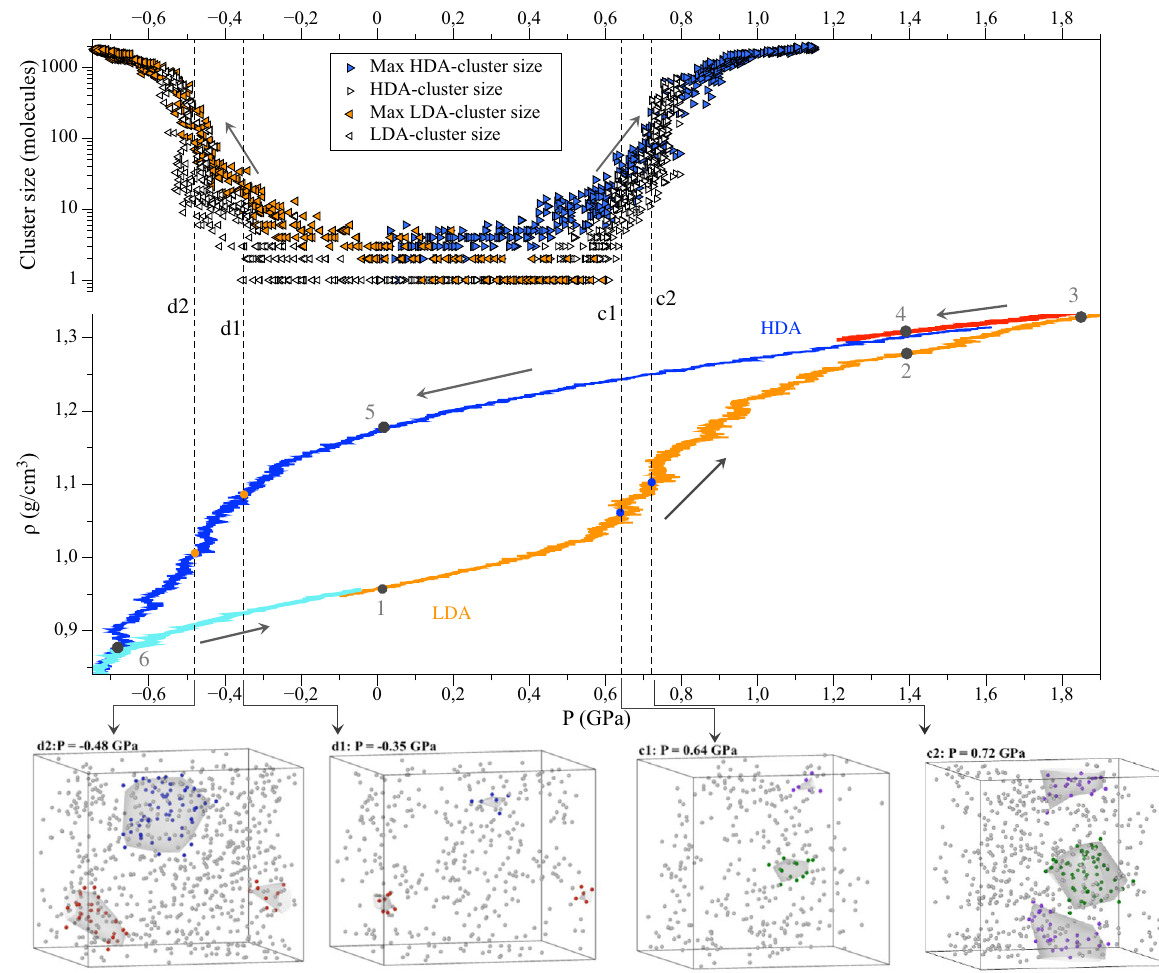
Figure 4. The pressure dependence of density during the transformations of amorphous ices under pressure at T = 77 K , the compression rate is 0.1 GPa/ns. The arrows indicate the cycle direction. On the route 4 → 5 , the blue line is the decompression of HDA obtained during SSA from Ih, the red line 3 → 4 is the decompression of HDA obtained from LDA. The cyan line 6 → 1 is the compression of LDA obtained from HDA. In the upper part of the plot, there is the pressure dependence of the size of the largest cluster defined according to our selection rules with the thresholds N descr (cid:31) 5 for LDA and N descr (cid:31) 11 for HDA: the blue right triangles show the maximum HDA-cluster size during the compression of LDA and the orange left triangles show the maximum LDA-cluster size during the decompression of HDA; the corresponding open right (left) triangles show the size of one selected smaller HDA (LDA) cluster. Below, the snapshots c1 and c2 demonstrate two HDA-clusters (their oxygen atoms are highlighted in green and purple) at pressures of 0.64 GPa and 0.72 GPa. The snapshots d1 and d2 demonstrate two LDA-clusters (their oxygen atoms are highlighted in blue and red) at pressures of −0.35 GPa and −0.48 GPa. Molecules with the same indices present in the clusters of one color that is why the snapshots illustrate the growth of clusters with